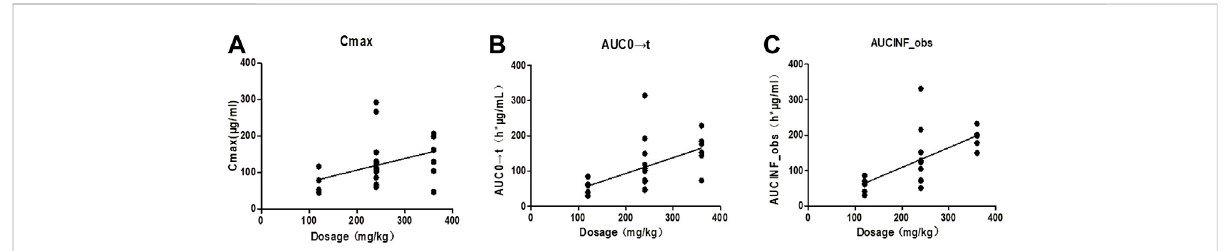
FIGURE 2 Correlation curves of pharmacokinetic parameters and dosage of each Beagle. Note: (A) . The correlation curve of Cmax/dose of each Beagle; (B) . The correlation curve of AUC0 → t/dose of each Beagle; (C) . The correlation curve of AUC0 → ∝ /dose of each Beagle.